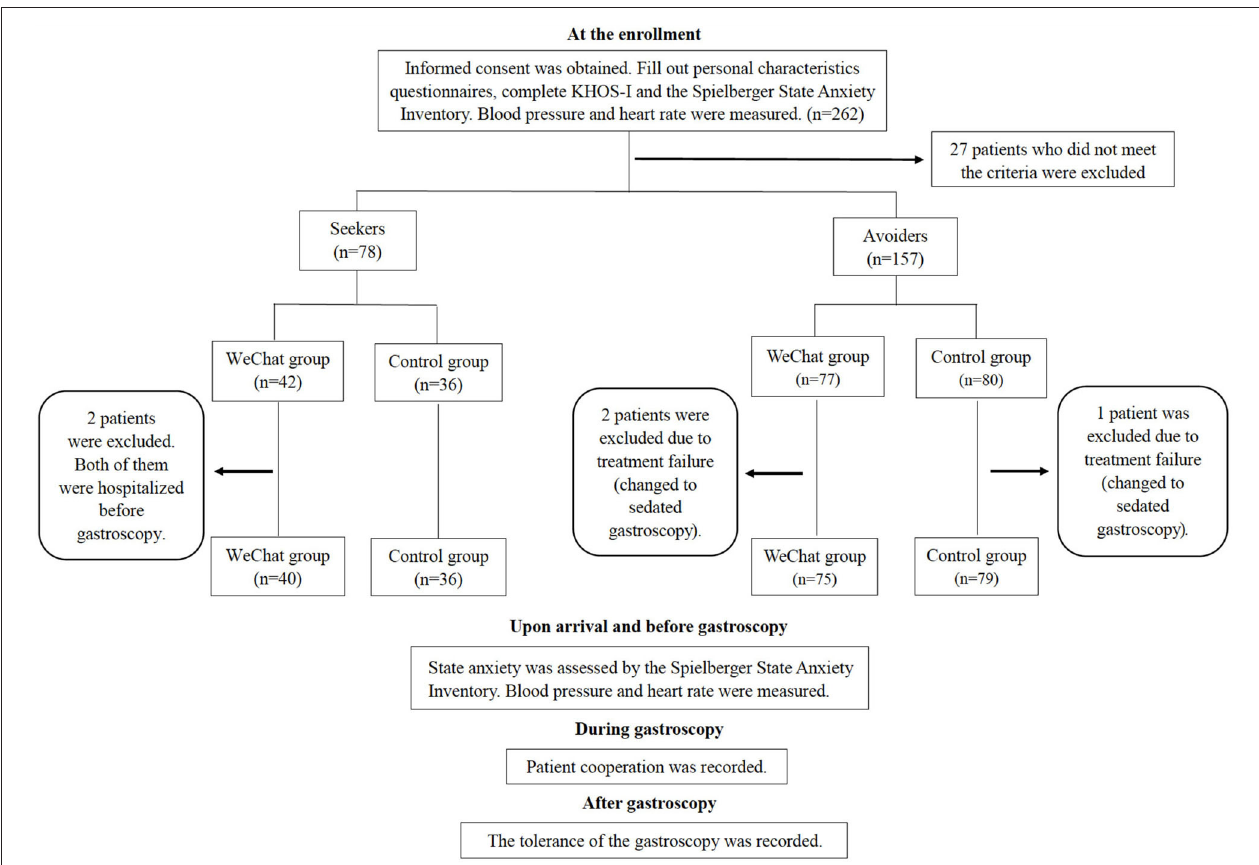
FIGURE 1 | The flowchart of procedure. KHOS-I indicates Krantz Health Opinion Survey.